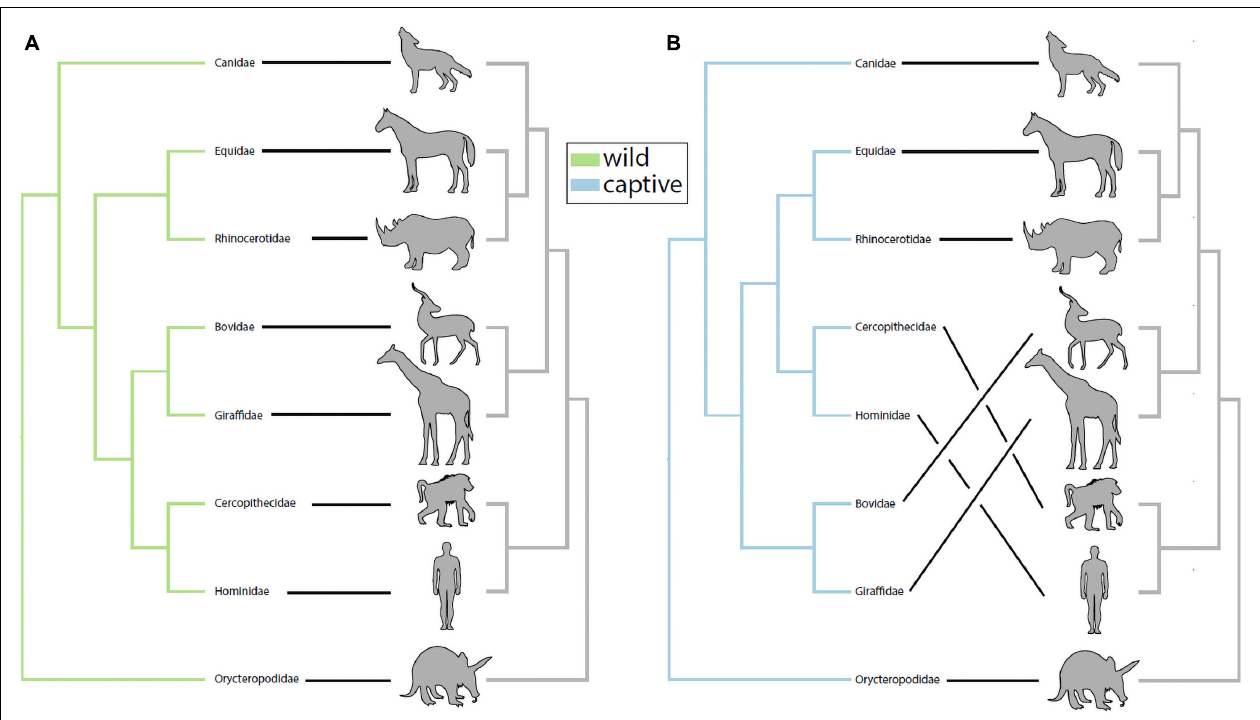
FIGURE 1 | Captivity alters patterns of phylosymbiosis among mammalian families. (A) UPGMA-clustered microbiota dendrograms from wild mammals exhibited significant patterns of phylosymbiosis with host phylogeny (rooted Robinson-Foulds = 0.333, P = 0.0003). (B) UPGMA-clustered microbiota dendrograms from captive mammals also exhibited significant patterns of phylosymbiosis with host phylogeny (rooted Robinson-Foulds = 0.333, P = 0.0002). Although wild and captive trees both exhibited significant patterns of phylosymbiosis, further inspection revealed that captive Equidae and Rhinocerotidae grouped more closely with primates compared to wild confamiliars in (A)